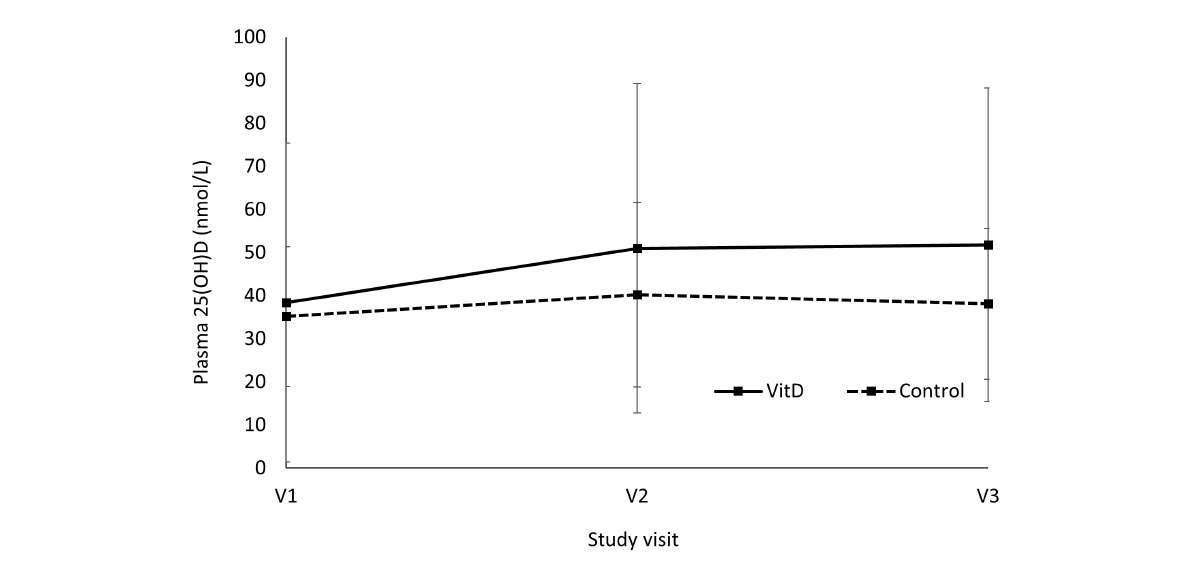
FIGURE2 Changes of plasma 25(OH)D concentrations between vitamin D and control group. V1 = visit 1, baseline; V2 = visit 2, after 6 weeks; V3 = visit 3, after 12 weeks. Main effect of visit, F (2,34) = 17.670, P < 0.001, η p 2 = 0.510; Visit*Treatment interaction, F (2,34) = 9.214, P = 0.001, η p 2 = 0.352; V1 vs. V2, P < 0.001; V1 vs. V3, P < 0.001; V2 vs. V3, P = 1.00, using two-way repeated measures ANOVA.